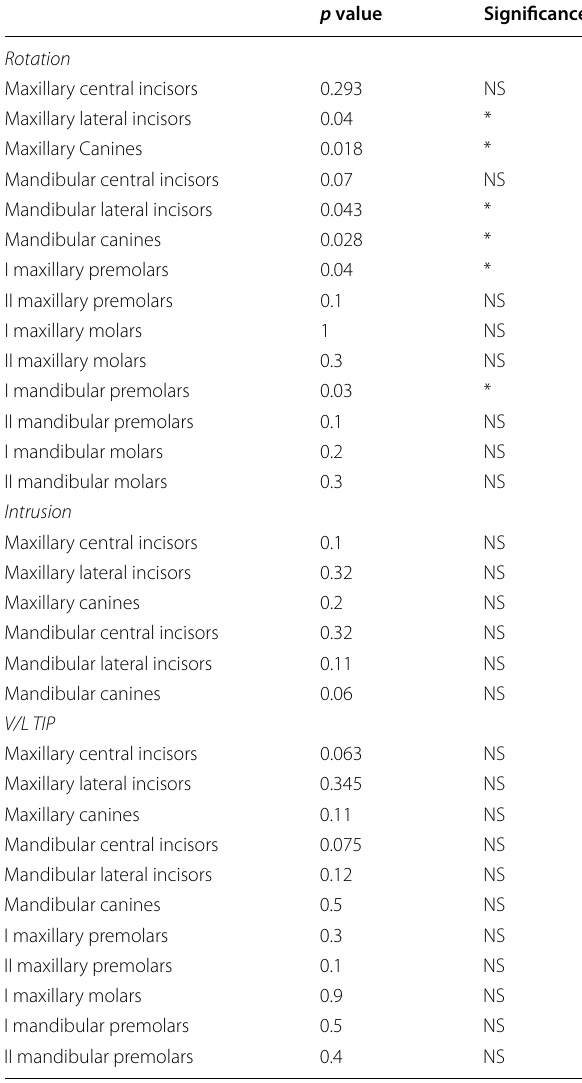
The asterisk indicates those values statistically significant ( p <